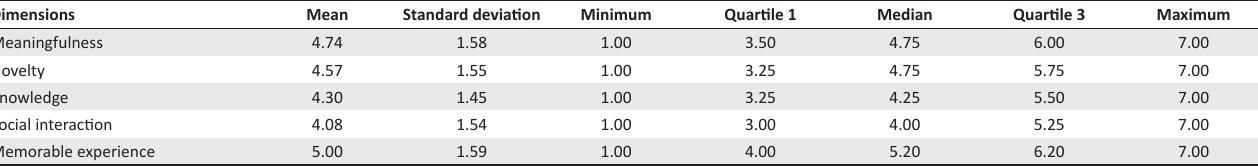
TABLE 2: Descriptive statistics for the cognitive dimensions of a memorable marine tourism experience.